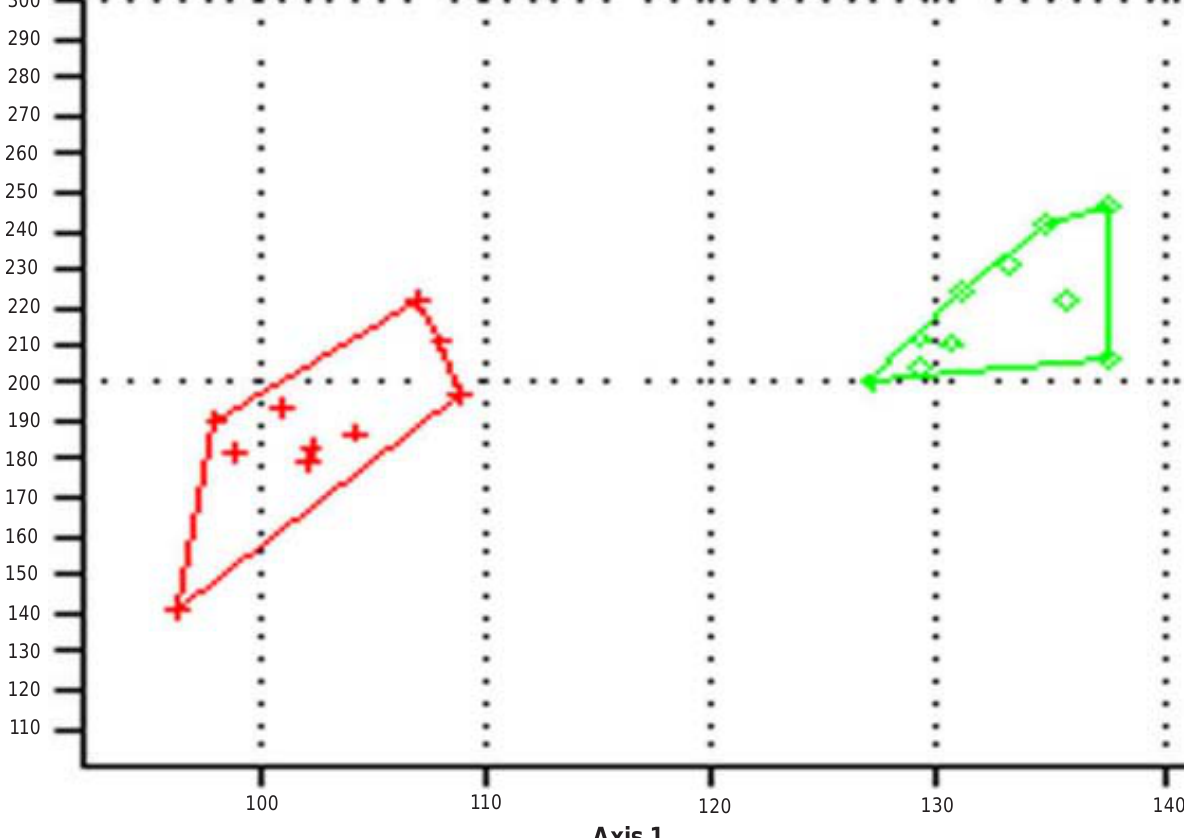
Figure 12. Polygons formed on the projection of male and female wings on to the MANCOVA variables 1 and